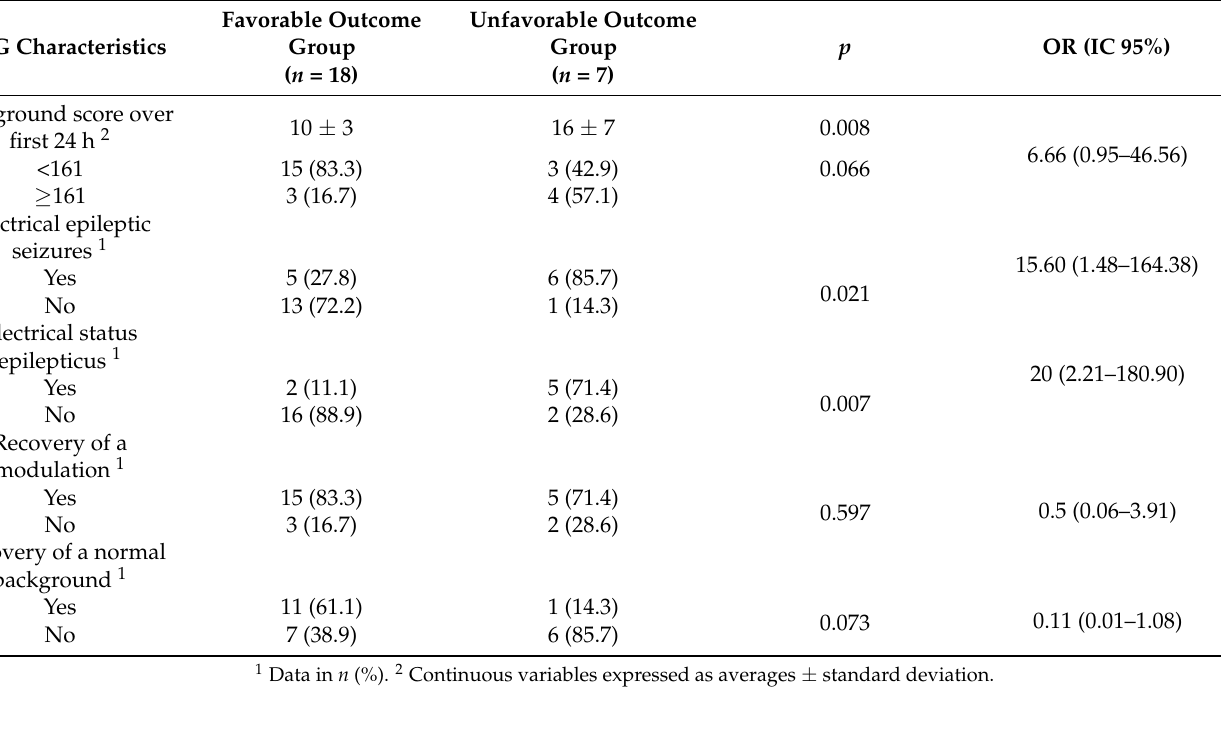
Table 3. Prognostic value of aEEG features during recording.